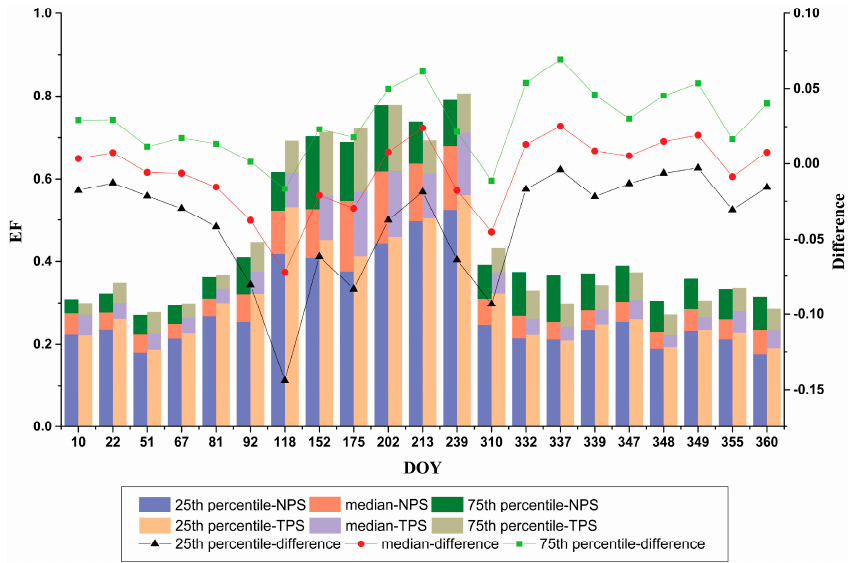
Figure 11. Temporal variations of the spatial quantile statistics of EF retrieved from these two parameterization schemes as well as the spatial quantile statistics of their differences ( EF NPS − EF TPS ) at daily scale.